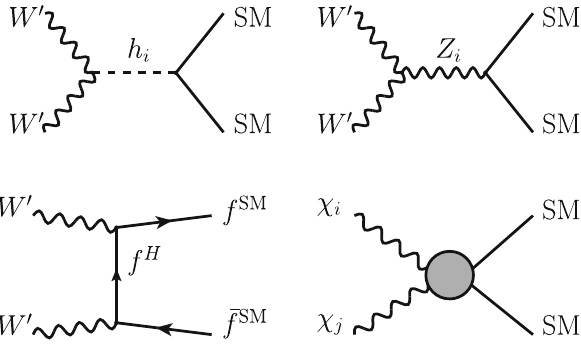
Fig. 7 TheDMannihilationandcoannihilationprocessesinthemodel. The top left, top right and bottom left panels represent the DM annihi- lation processes mediated by the scalar h i , the neutral gauge boson Z i via the s -channel and the heavy hidden fermions f H via the t -channel, respectively. The bottom right panel indicates the DM coannihilation processes where χ i = { W (cid:3) , H ± , D } and i (cid:14)= j